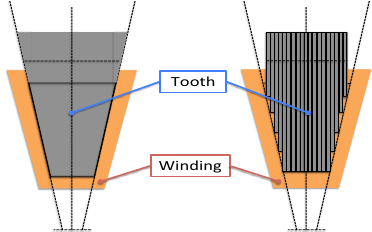
Figure 11: 3-D elements mesh for numerical analysis.